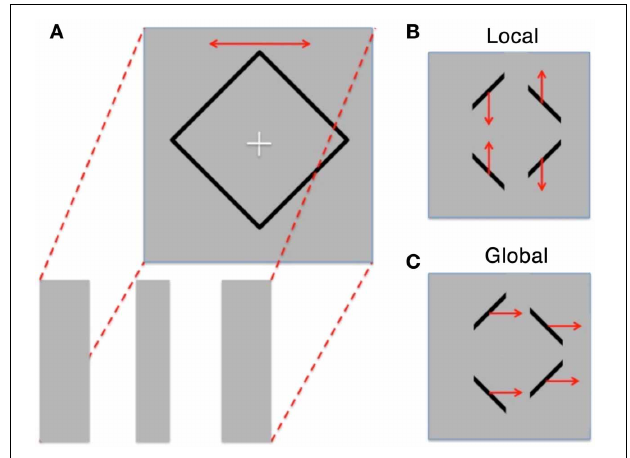
FIGURE 1 | (A) Schematic of the diamond illusion showing the diamond shapeoscillatinghorizontallybehindthreeoccludingstripesofthesamecolor and luminance as the background. (B) Resultant perception is either “Local” with 4 lines moving up and down or (C) . “Global” perception where the motion of the lines is grouped and they are seen as moving horizontally back and forth (redrawn from Fang et al.,